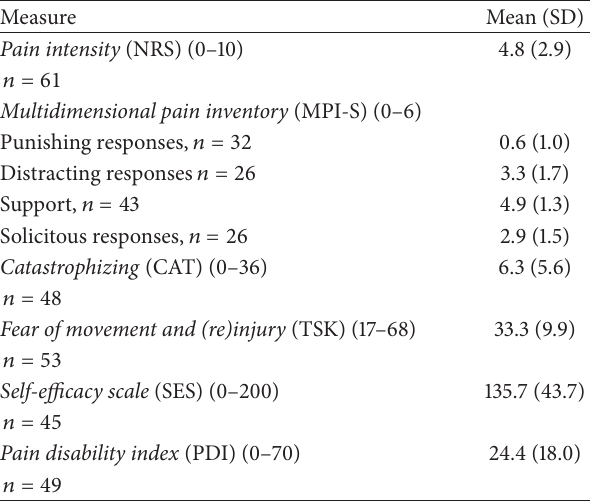
Table 1: Means and standard deviations for the studied variables in the